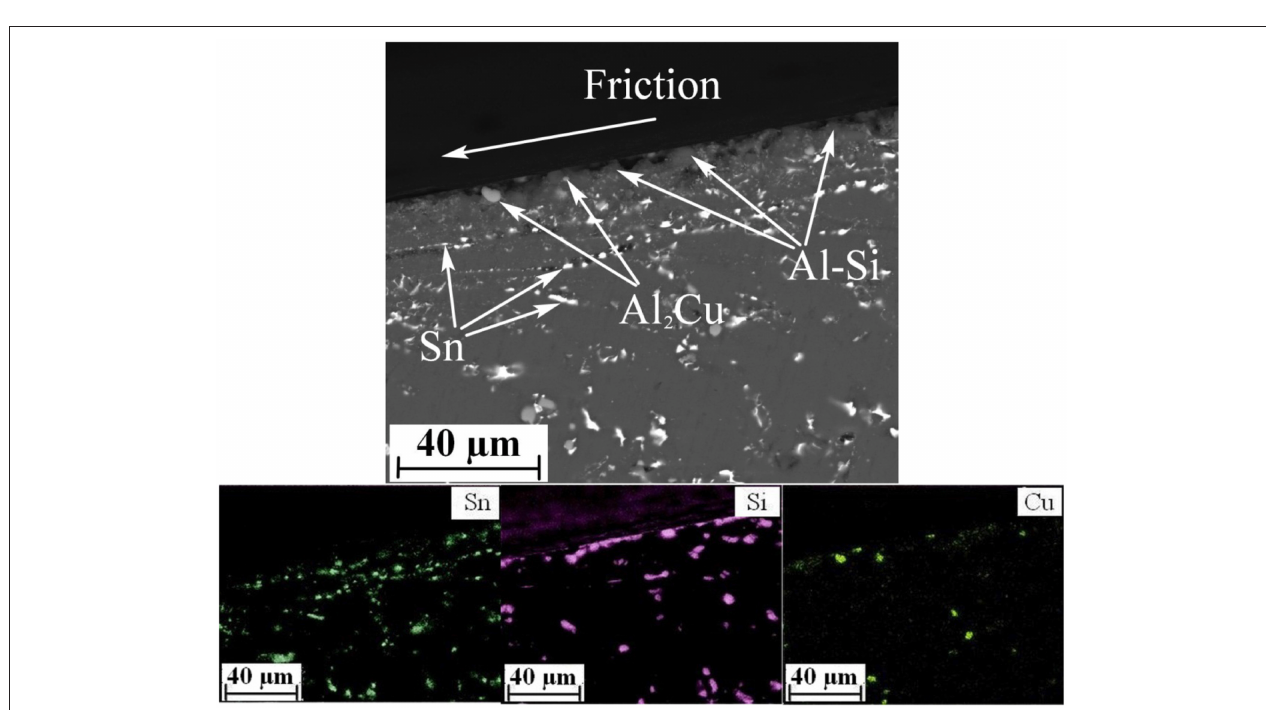
FIGURE 8 | SEM image (in secondary electrons) of the surface of transversal section of the shoe (alloy No. 1) after tribological tests with lubrication. Corresponding mapping (the main alloying elements).